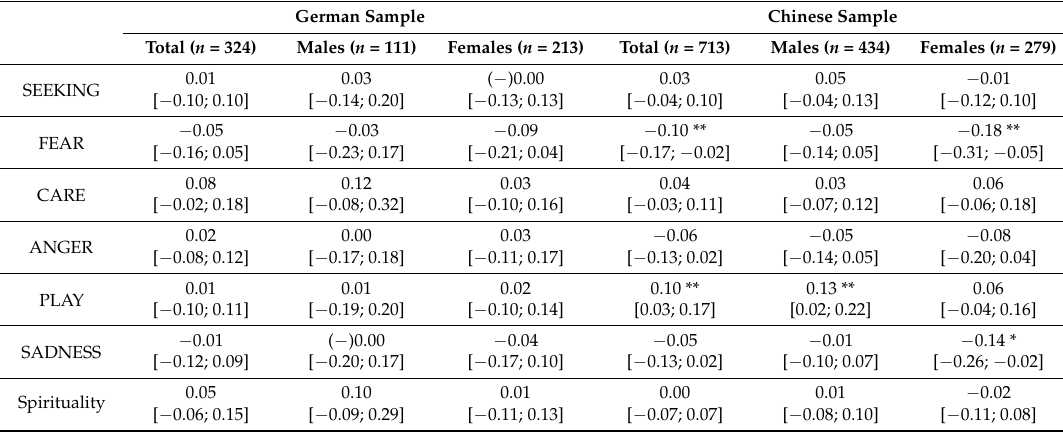
Table 4. Partial correlations (controlled for age) and 95% confidence intervals between the urbanicity index and the ANPS scales. German